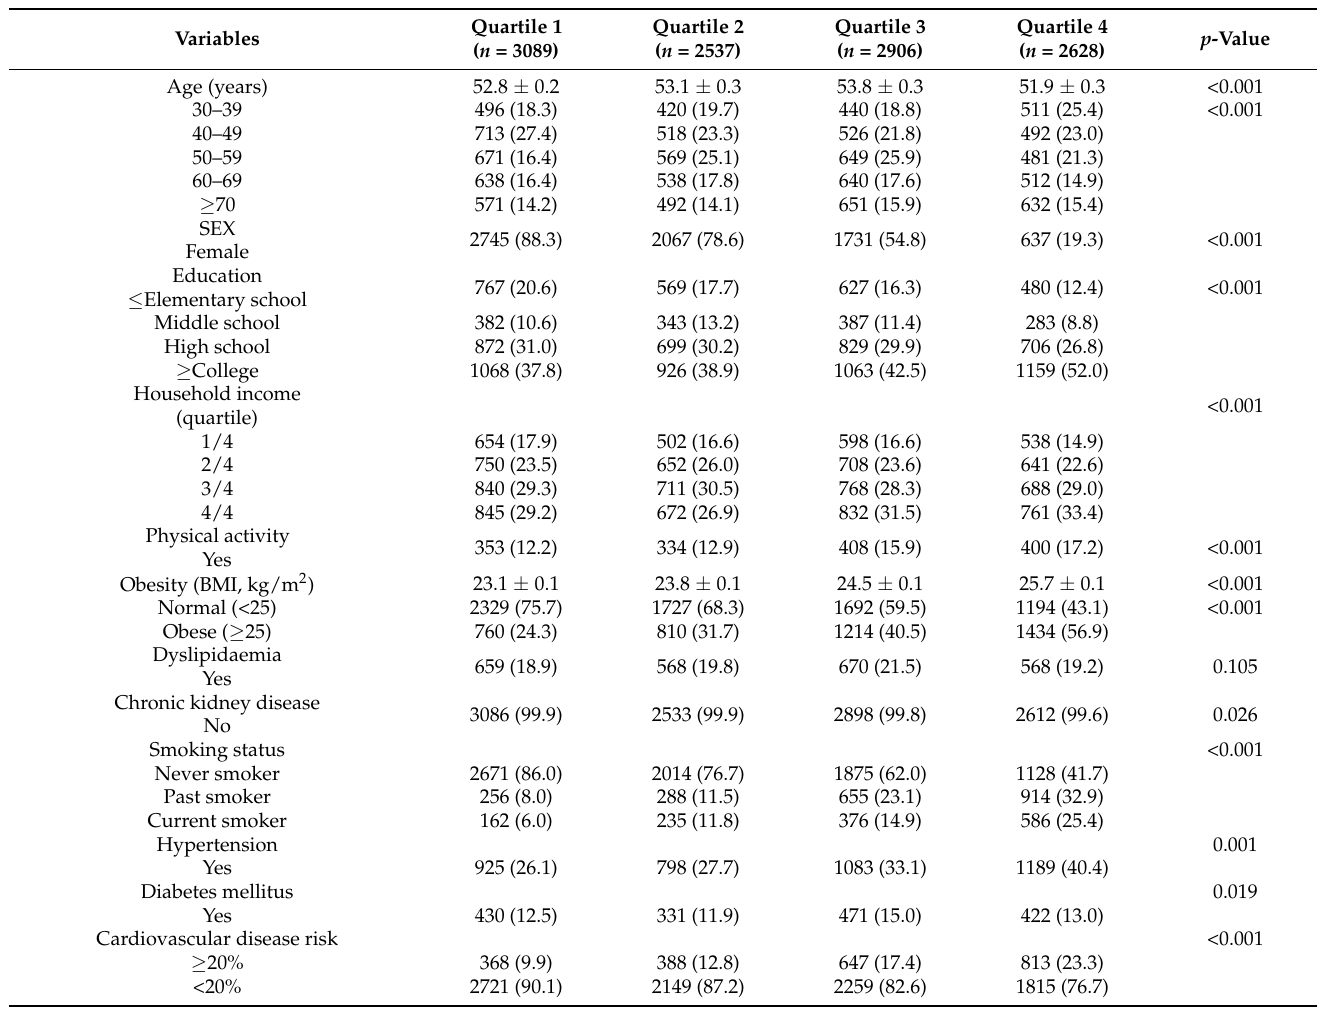
Table 1. Baseline characteristics of the participants according to serum uric acid